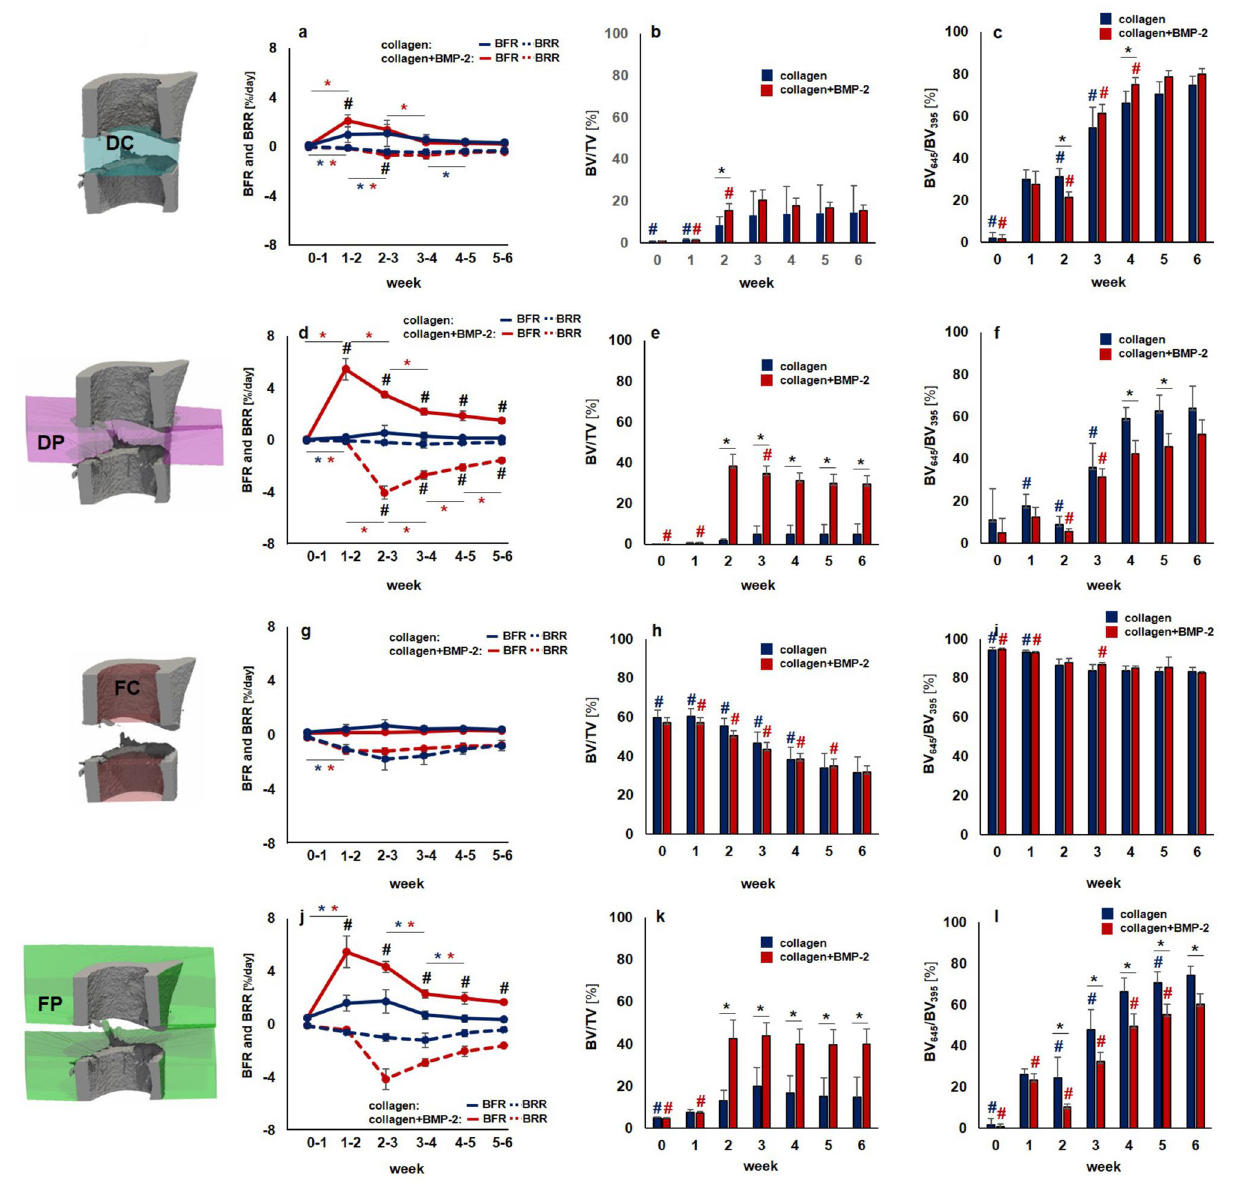
Figure 4. Micro-CT based evaluation of bone parameters in the collagen group (blue) and the collagen + BMP-2 group (red) using different VOIS: defect center (DC; a – c ), defect periphery (DP; d – f ), cortical fragment center (FC; g – i ), cortical fragment periphery (FP; j – l ). ( a , d , g , j ) Bone formation rate (solid line) and bone resorption rate (dashed line) given in percent per day. ( b , e , h , k ) Bone volume (BV) normalized to TV (DC for DC and DP, FC for FC + FP). ( c , f , i , l ) Degree of bone mineralization given as ratio of bone volume with a density ≥ 645 mg HA/cm 3 to the total osseous volume (threshold ≥ 395 mg HA/cm 3 ). n = 7/10; ( a , d , g , j ) *indicates p < 0.05 between consecutive weeks; # indicates p < 0.05 between groups. ( b , c , e , f , h , I , k , l ) *indicates p < 0.05 between groups; # indicates p < 0.05 between consecutive